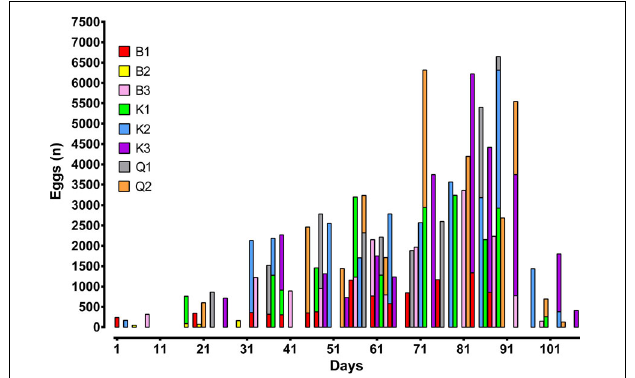
MWW but the observed mortality should not be disregarded ( Table 2 ). MWW was higher in tanks with 9000L volume and higher area when compared with 3000L, but no difference was seen regarding the effects of available bottom area in the 9000L